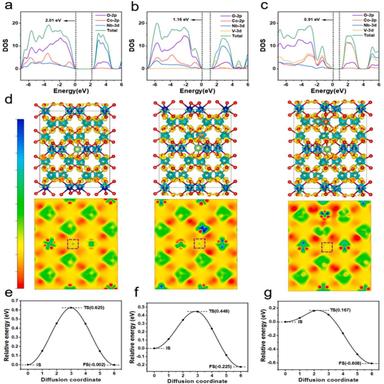
Calculated density of states for (a) CNO, (b) substitutional doped CNO, and (c) interstitial doped CNO; (d) 3D charge difference and 2D charge difference of CNO with different doping amounts; Calculated Li+ diffusion energy barriers of (e) CNO, (f) substitutional doped CNO, and (g) interstitial doped CNO.